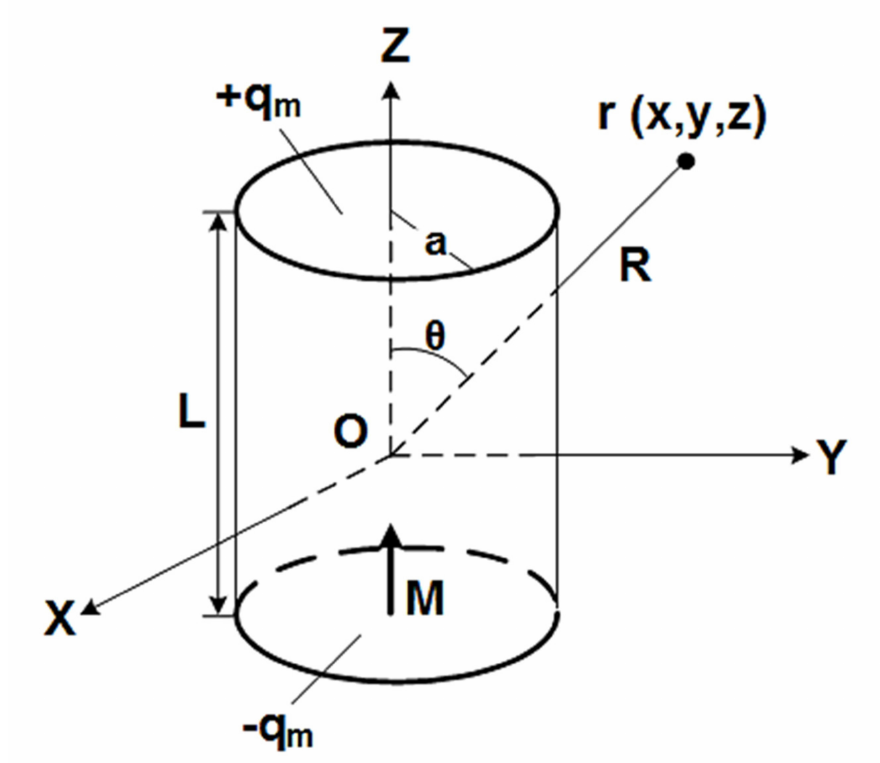
Figure 2. Model of the ferrite